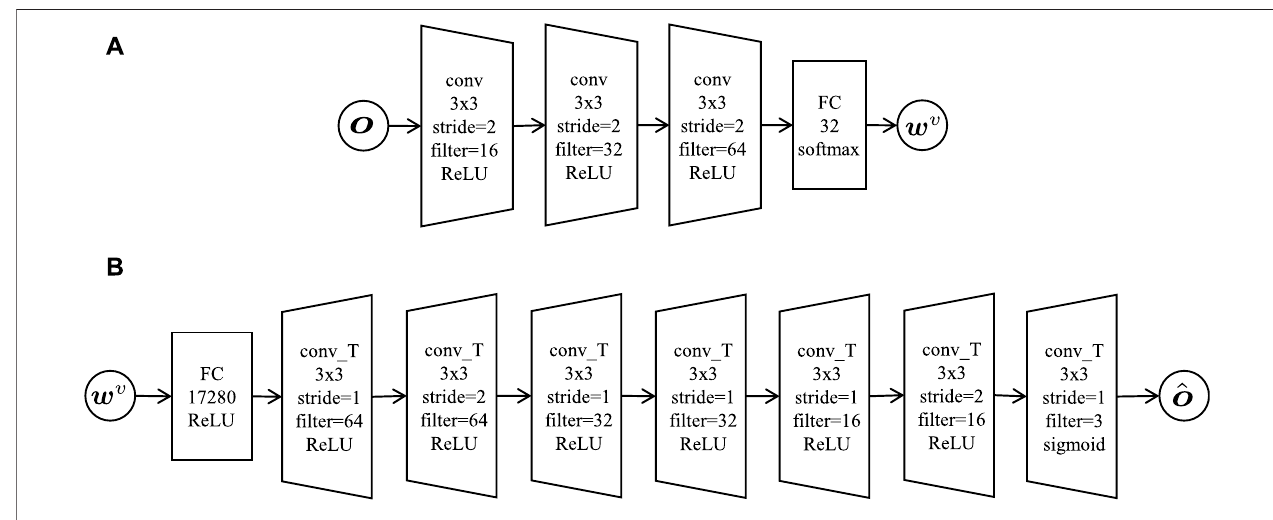
FIGURE4| NetworkarchitectureofMNVAE: (A) encoderconsistingofthreeconvolutionallayers(conv)andafullyconnectedlayer(FC)and (B) decoderconsisting of an FC layer and seven deconvolutional layers (conv_T).